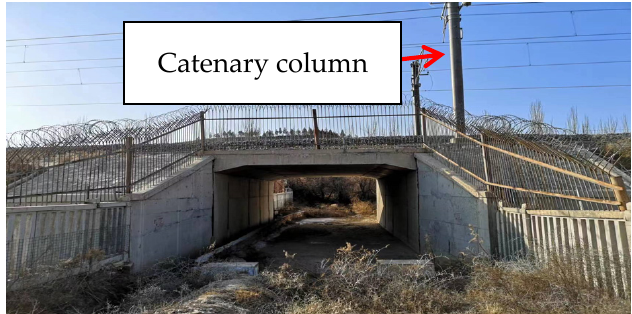
Figure 4. The position diagram of the catenary column and culvert (Site 1).